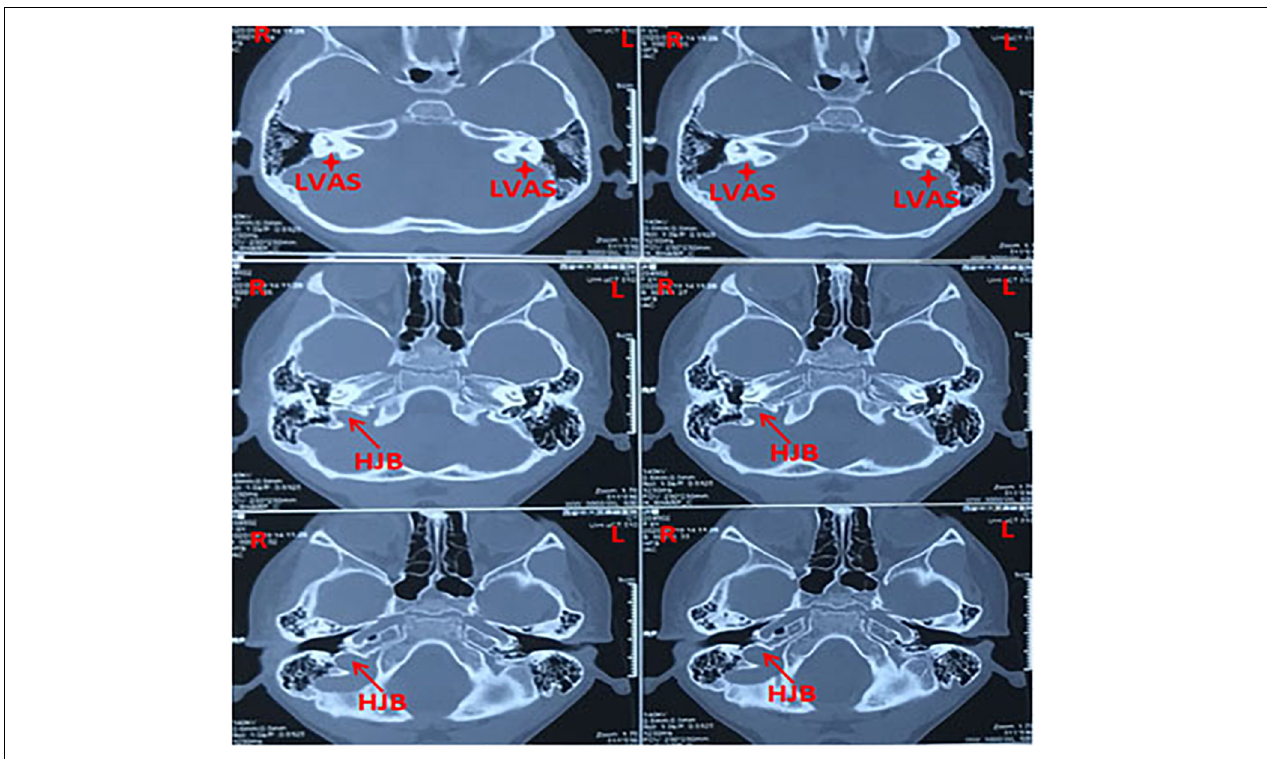
FIGURE 1 | Representative CT (computed tomography) scan images showing bilateral large vestibular aqueduct syndrome with unilateral high jugular bulb (right ear) from a 3-years-old patient.